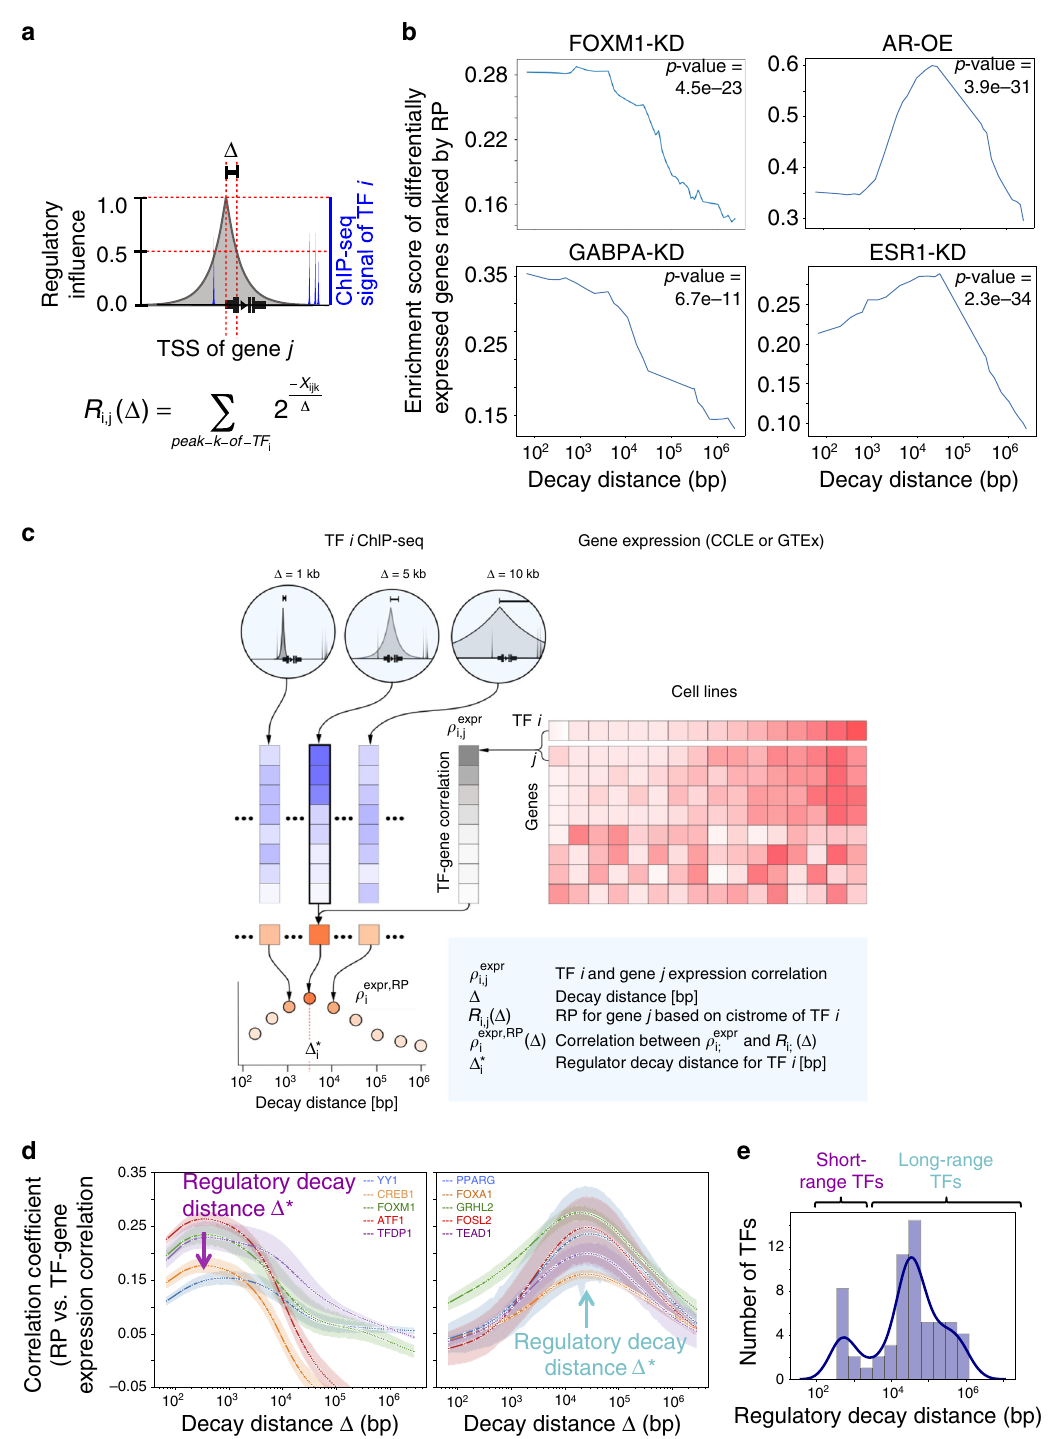
Regulatory decay distance (bp) Decay distance Δ (bp) Decay distance Δ (bp) We fi rst inferred the Δ * using the Cistrome DB TF ChIP-seq across different These analysis yielded similar estimates of Δ * i i collection 3 and gene expression data across ~1000 cell lines from gene expression cohorts using both linear and nonlinear is <1 kb for some the Cancer Cell Line Encyclopedia (CCLE). Δ * approaches (Methods, Supplementary Fig. 2d – e). Moreover, for i TFs such as YY1 , CREB1 , FOXM1 , ATF1, and TFDP1 (Fig. 1d left, the same TF, the inferred Δ * is similar in different tissues i Supplementary Fig. 2b left), but is >10 kb for TFs such as PPARG , (Supplementary Fig. 2f). Of 108 TFs with at least three ChIP-seq FOXA1 , GRHL2 , FOSL2 , and TEAD1 (Fig. 1d right, Supplemen- samples containing at least 20,000 peaks in Cistrome DB 3 , we tary Fig. 2b right). We repeated the analysis above using another identi fi ed 60 TFs with at least three ChIP-seq samples that yielded fi ve gene expression cohorts 20 – 24 , and further used Genotype- estimates in at least three gene expression cohorts signi fi cant Δ * i (methods). Tissue Expression (GTEx) 9 to infer tissue-speci fi c Δ * (Supplementary Data 1). We observed a distribution of Δ * i i NATURE COMMUNICATIONS| (2020) 11:2472